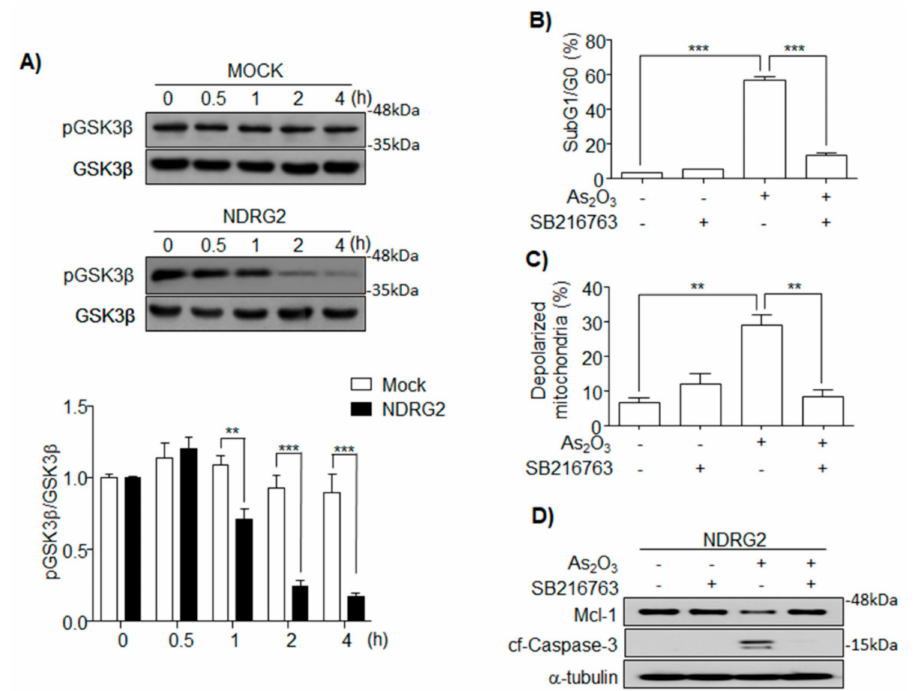
Figure 3. As 2 O 3 -induced glycogen synthase kinase 3 β (GSK3 β ) activation regulates Mcl-1